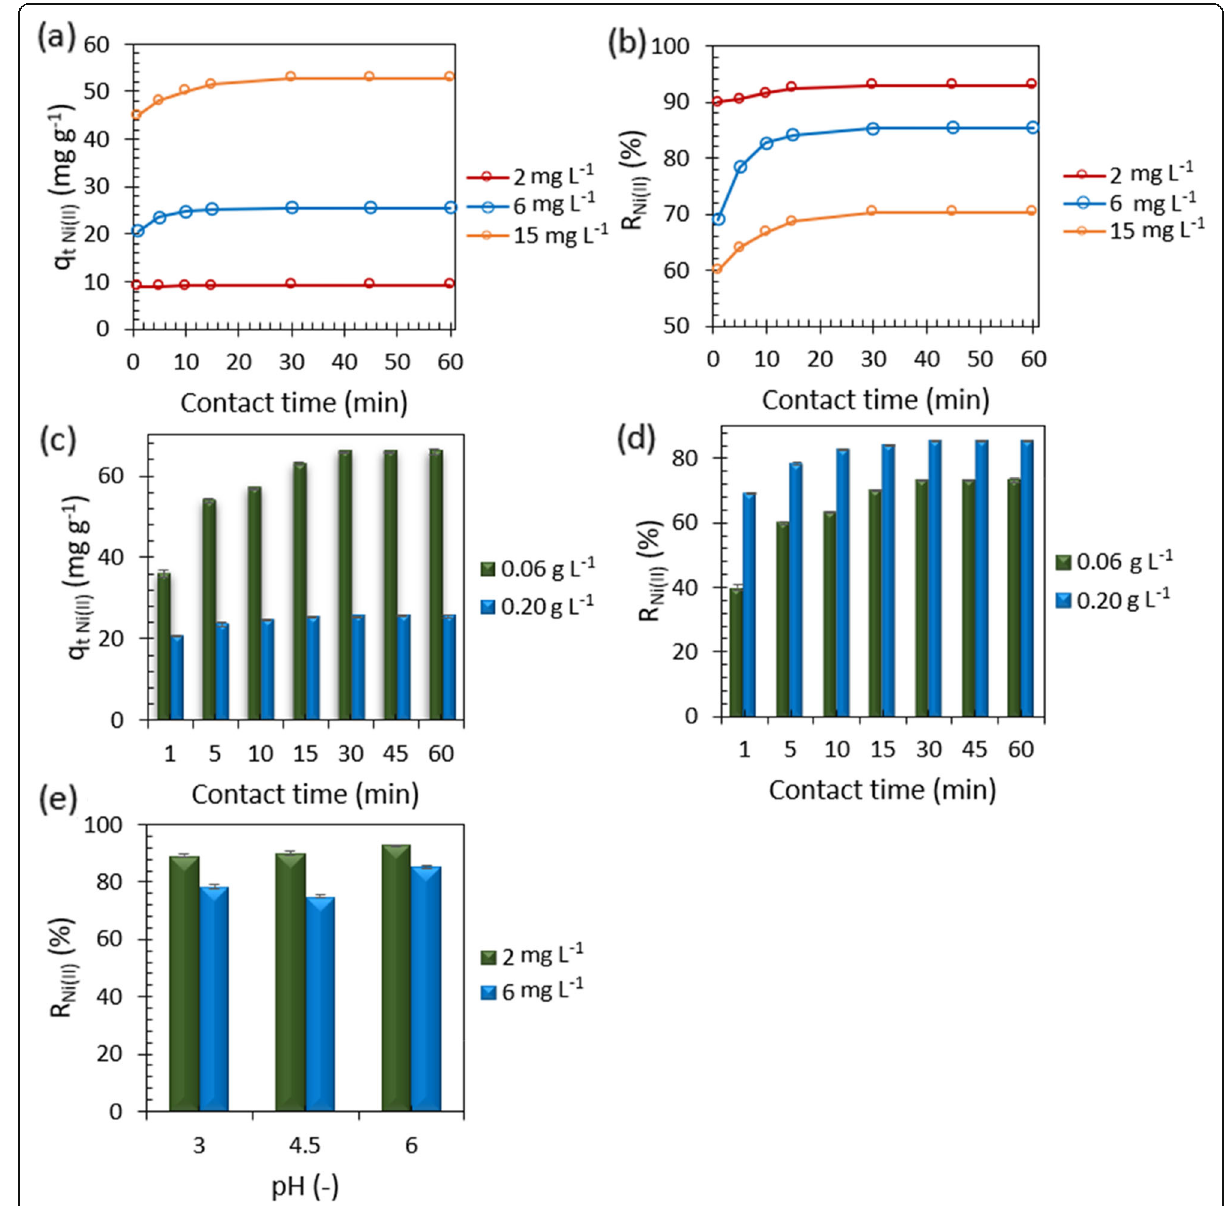
Fig. 3 Effect of rGO-X-25 on the ( a ) uptake capacity and ( b ) removal of Ni (II) within 1 h of contact time at various initial Ni (II) concentrations, rGO dose = 0.20 g L − 1 , and pH = 6. ( c , d ) rGO-X-25 dose effect on uptake capacity and (b) Ni (II) removal at 6 mg L − 1 , and pH = 6. ( e ) pH effect on Ni (II) removal; 2 and 6 mg L − 1 at contact time = 30 min and rGO dose = 0.20 g L −